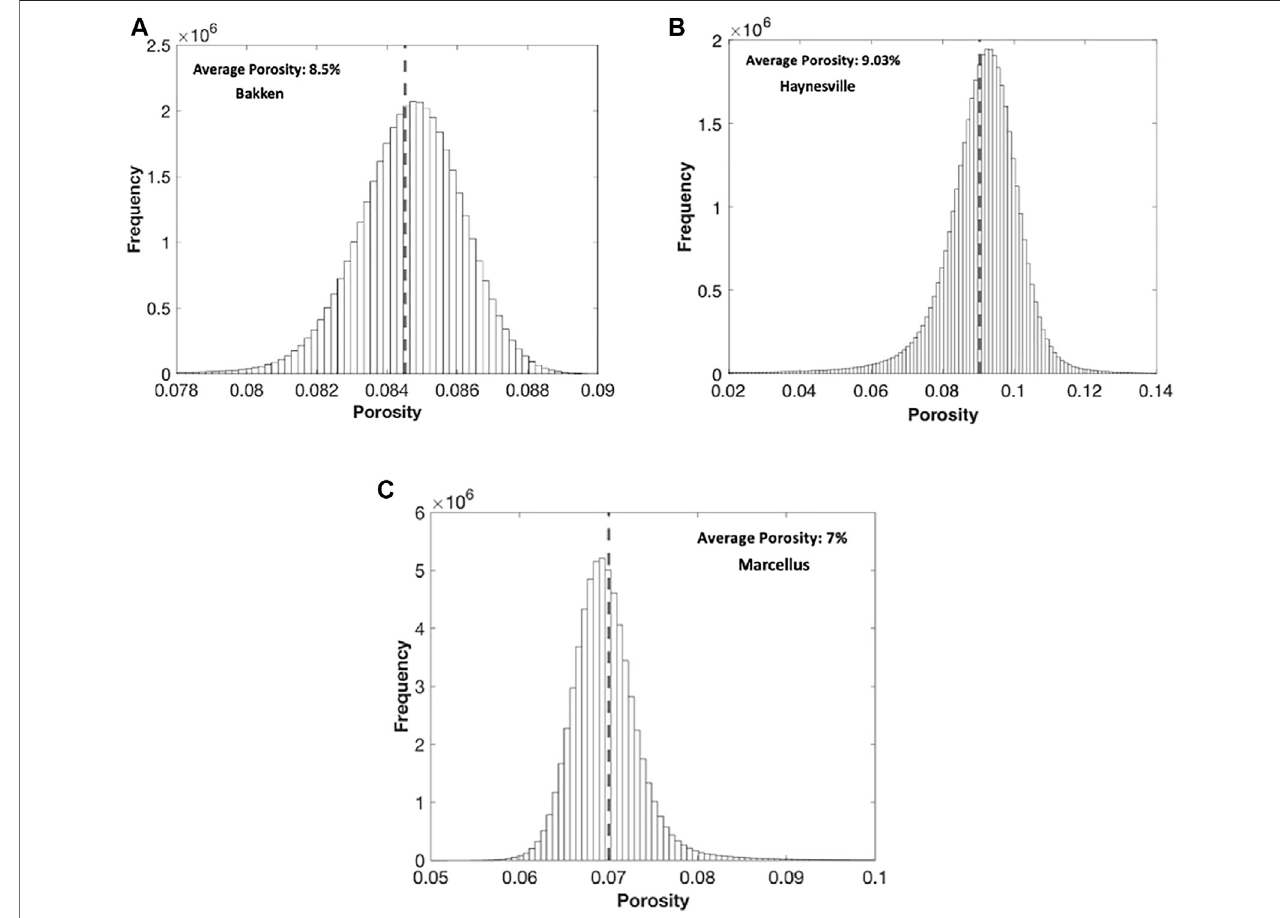
FIGURE 3 | Porosity distribution for each sub-volume of the (A) Bakken, (B) Haynesville and (C) Marcellus shale sample.